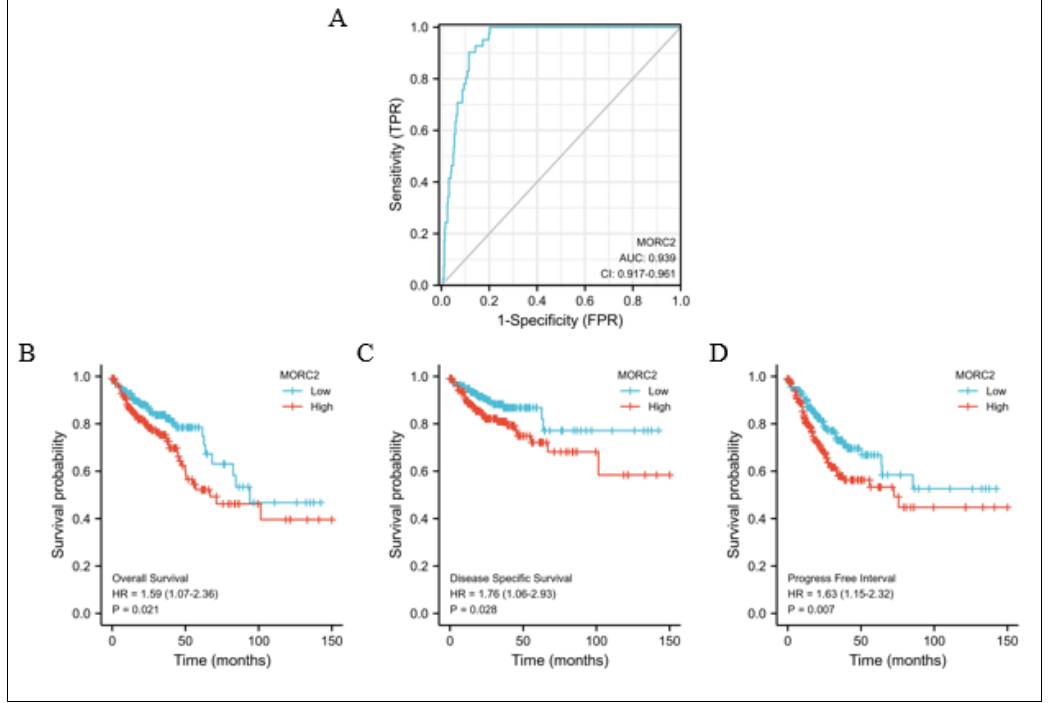
Figure 6. Predictive value of MORC2 expression for diagnosis and clinical outcomes in CRC patients. ( A ) ROC curve analysis evaluating the performance of MORC2 for CRC diagnosis. ( B – D ) Shown are the Kaplan – Meier analyses comparing overall survival, disease-specific survival, and progression-free interval between high- and low-MORC2 expression groups.